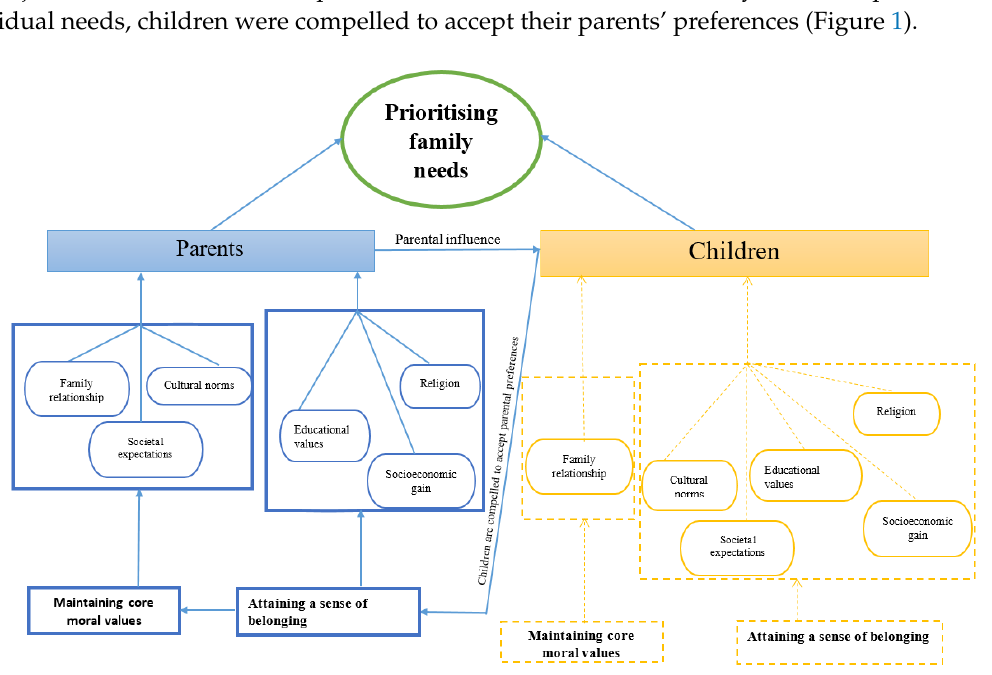
Figure 1. Prioritising family needs model for African immigrant families. Maintaining core moral values and attaining a sense of belonging were the two main categories identified. Solid dark lines signify parental preferences while the broken lines signify the children’s preferences. Parents maintained core moral values (heritage culture) in terms of family relationship, cultural norms and societal expectations, while attaining a sense of belonging in terms of educational values, religion and socioeconomic gains. On the other hand, children preferred to attain a sense of belonging (identify with the host culture) with respect to cultural norms, societal expectations, educational values, religion and socioeconomic gains. Family relationship was the only aspect for which children maintained core moral values (heritage culture). However, the parental preferences overrode the children’s preferences and the children were compelled to accept parental preferences, as family needs are valued over individual needs.